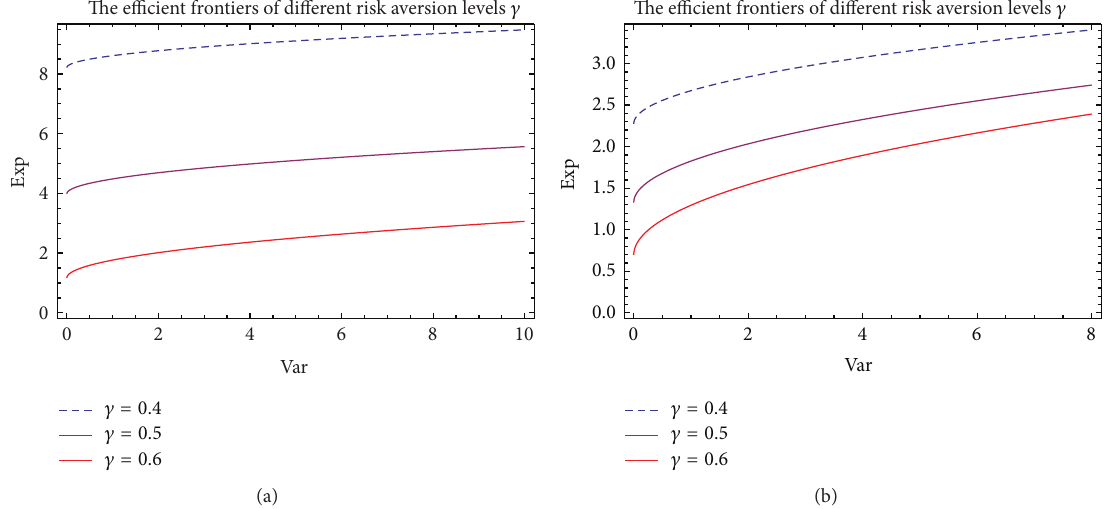
Figure 5: (a) The efficient frontiers of different risk averse level 𝛾 when 𝑡 = 21 . (b) The efficient frontiers of different risk averse level 𝛾 when 𝑡 = 28